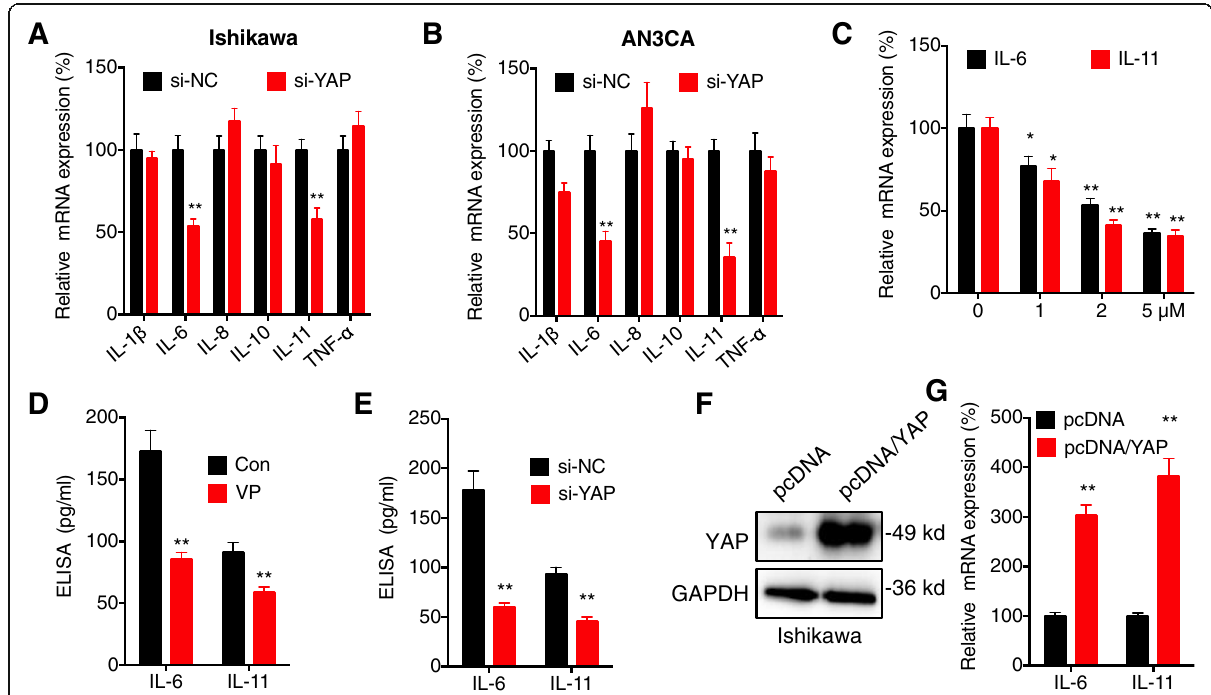
Fig. 3 YAP can regulate the expression of IL-6 and IL-11 in EC cells . Ishikawa ( a ) or AN3CA ( b ) cells were transfected with si-NC or si-YAP for 24 h, the mRNA expression of cytokines was measured by qRT-PCR; ( c ) Ishikawa cells were treated with increasing concentrations of VP for 24 h, the mRNA expression of cytokines was measured by qRT-PCR; ( d ) Ishikawa cells were treated with or without 1 μ M of VP for 24 h, the expression of cytokines was measured by ELISA; ( e ) Ishikawa cells were transfected with si-NC or si-YAP for 24 h, the expression of cytokine was measured by ELISA; Ishikawa cells were transfected with pcDNA vector or pcDNA/YAP for 24 h, ( f ) the protein expression of YAP was tested by western blot, ( g ) the mRNA expression of IL-6 and IL-11 was tested by qRT-PCR. *p < 0.05, ** p < 0.01 compared with